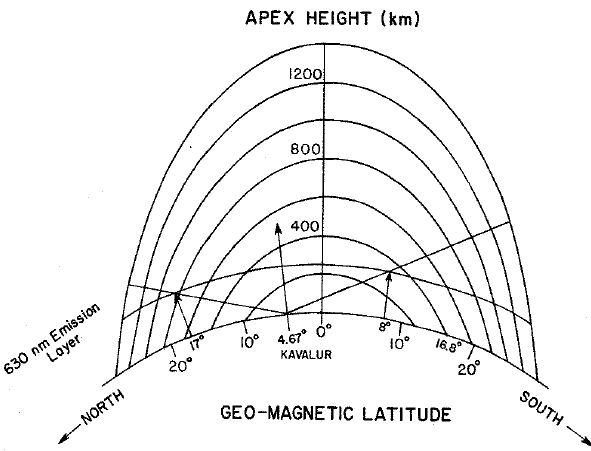
Fig. 1. Viewing geometry of the imager at Kavalur (12.56 ◦ N, 78.8 ◦ E, Mag. Lat 4.6 ◦ N). A field-of-view of ± 75 ◦ covers the 630nm emission from 17 ◦ N to 8 ◦